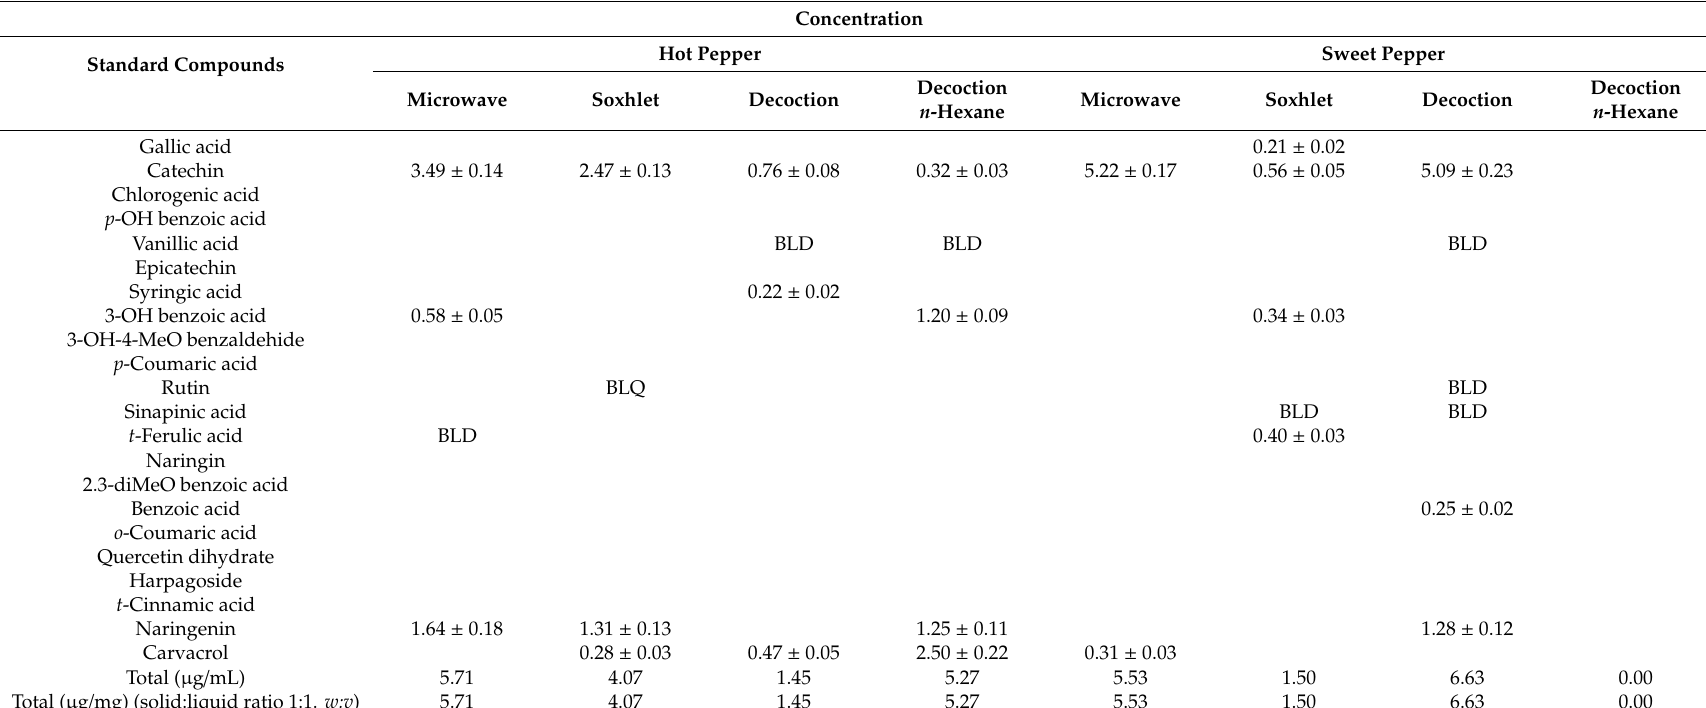
Table 2. Quantitative analysis on hot pepper and sweet pepper by means of the published